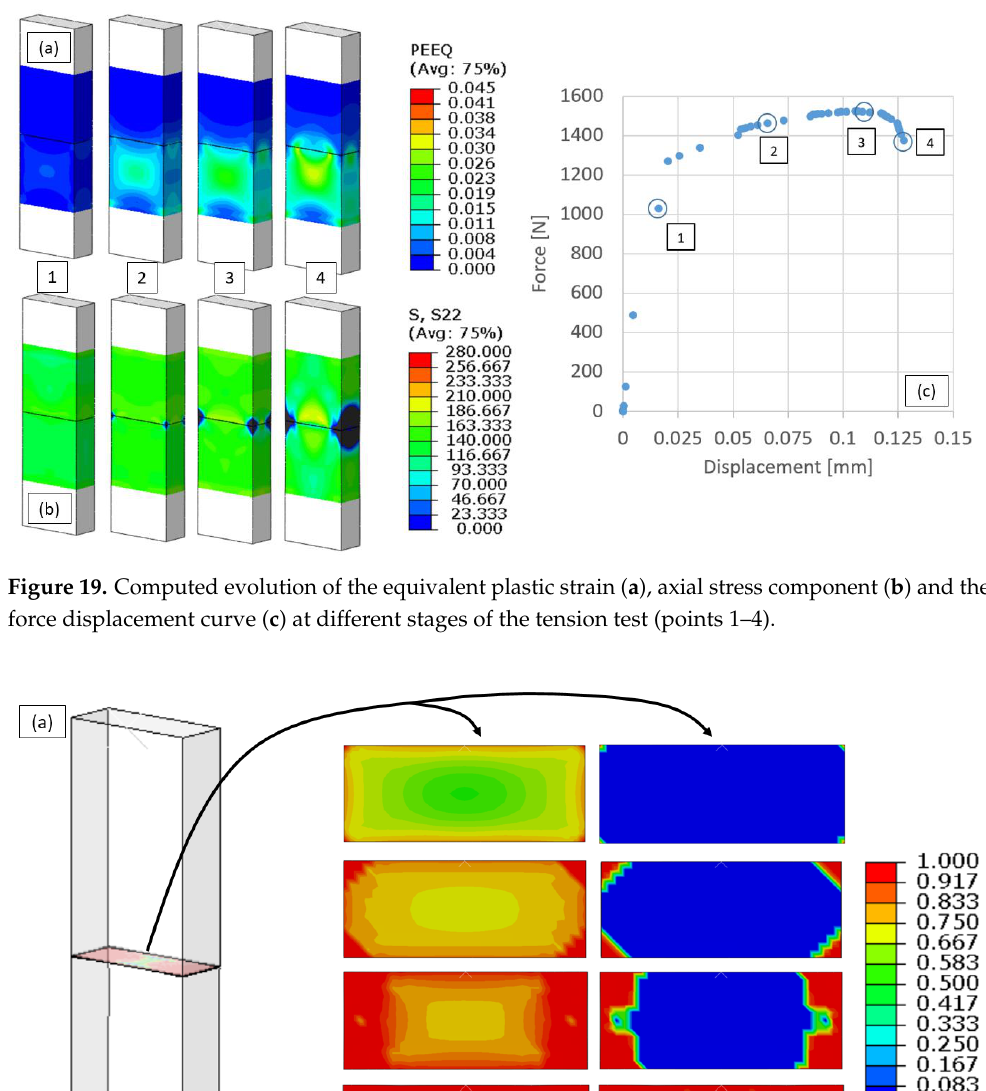
Figure 19. Computed evolution of the equivalent plastic strain ( a ), axial stress component ( b ) and the force displacement curve ( c ) at different stages of the tension test (points 1 – 4).